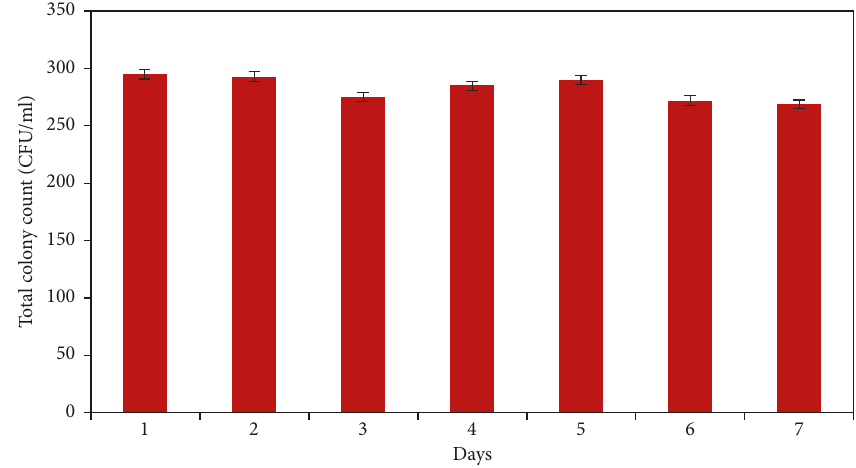
Figure 8: The total plate count of E. coli from day one to seven days at − 4 °